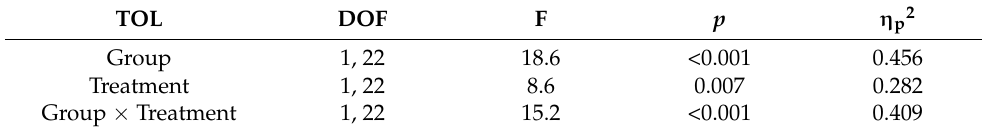
Table 2. ANOVA data for the TOL failed attempts. Degrees of freedom (DOF). TOL